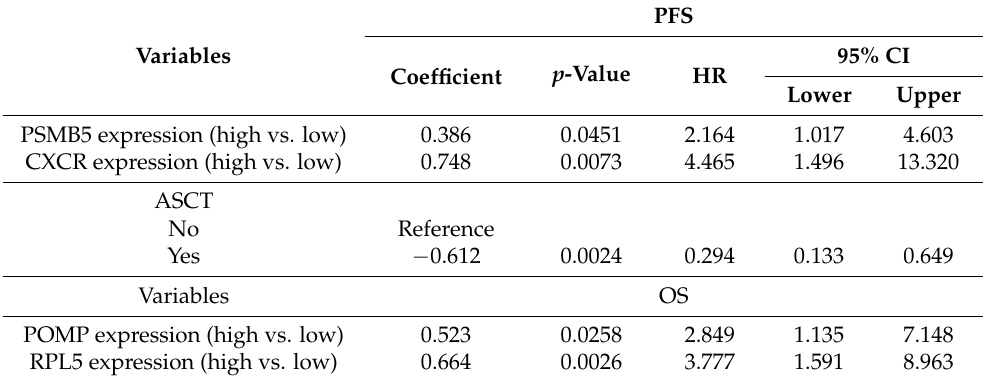
Table 5. Final multivariate Cox regression analyses for PFS and OS of MM